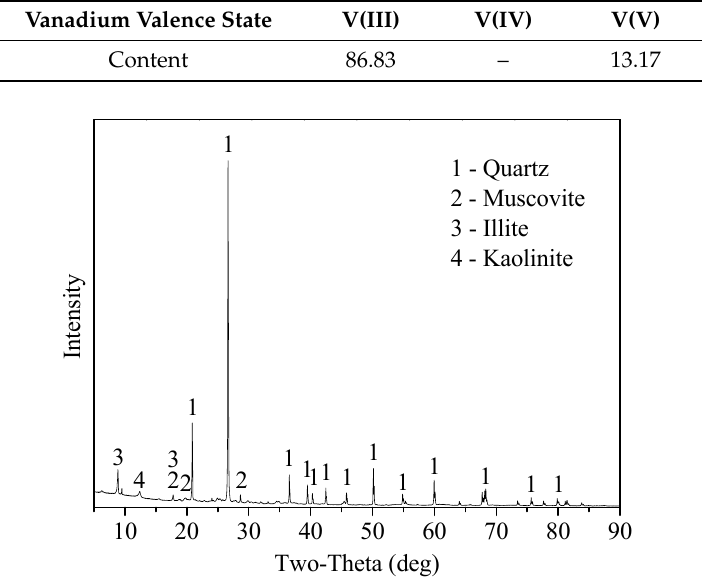
Table 2. Valence composition of vanadium in siliceous shale (wt %).